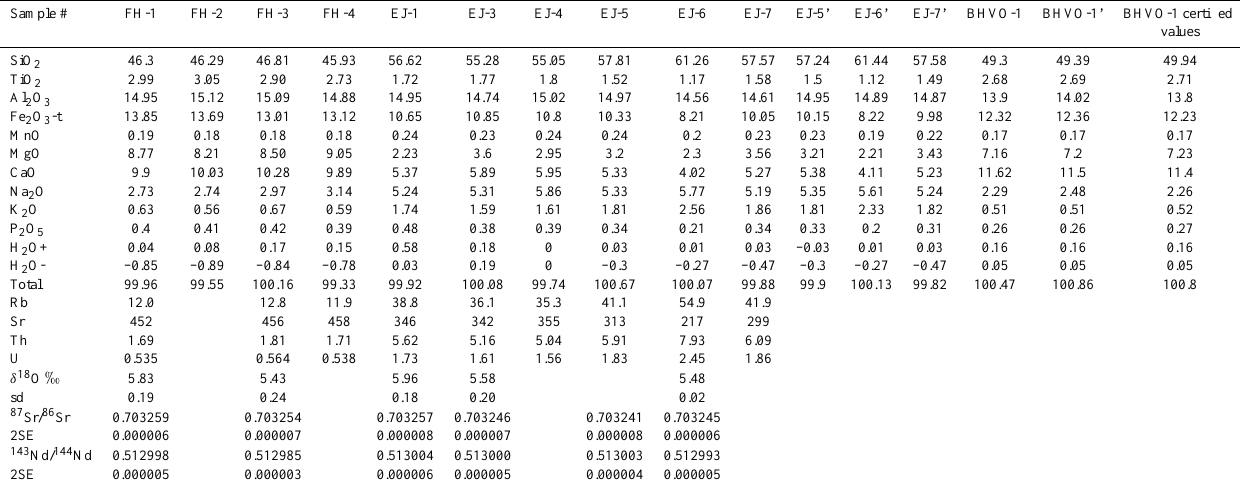
Table 1. Whole-rock major- and trace-element concentrations and Sr-, Nd- and O-isotope ratios in Eyjafjallajökull 2010 products. Sample